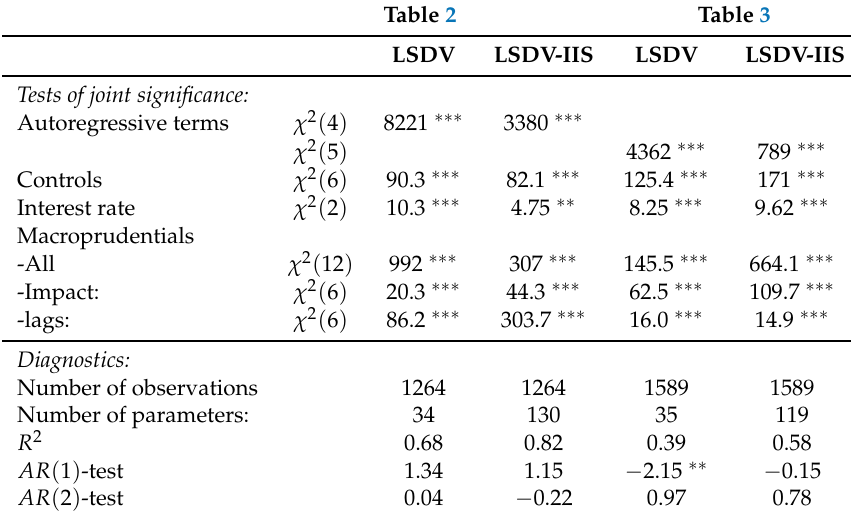
Table 4. Tests of joint significance and diagnostic